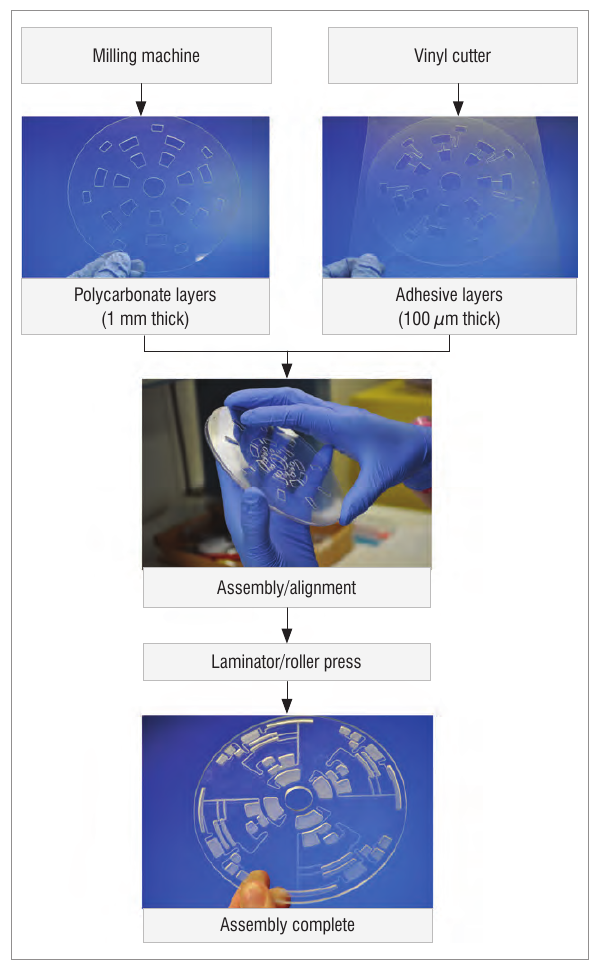
Illustration of microfluidic disc manufacture and assembly